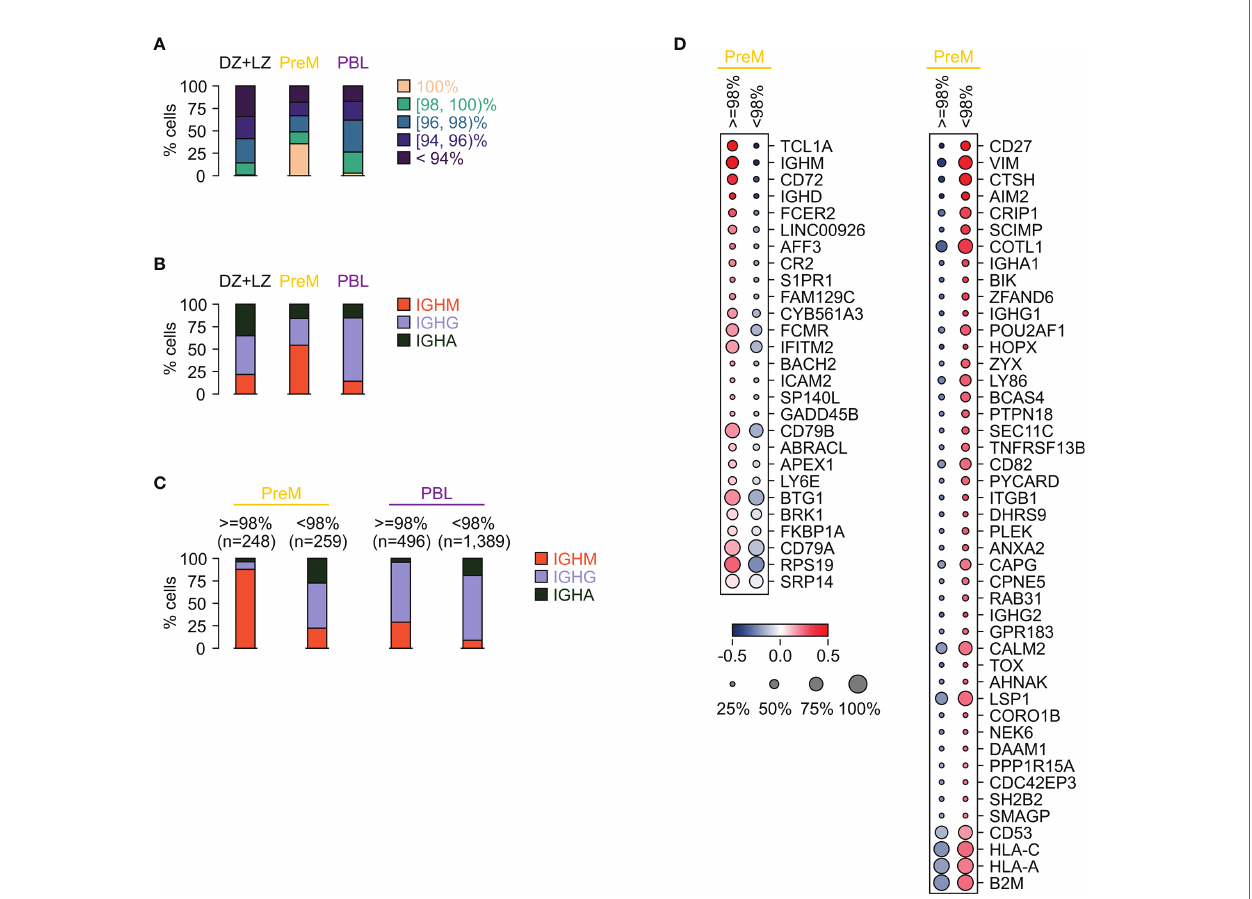
FIGURE 4 | PBL and PreM display unique immunoglobulin repertoires. (A) Stacked bar plot showing for the indicated cell populations, GC (DZ+LZ groups), PreM and PBL (PBL1+PBL2 clusters), the percentage of cells within the V-region germline identity subgroups. (B) Stacked bar plots showing for the indicated cell populations the percentage of cells within the immunoglobulin isotype classes. (C) Stacked bar plots showing for the PreM and PBL populations the percentage of cells within the immunoglobulin isotype classes in the fractions with high ( ≥ 98%) and low (<98%) V-region germline identity. (D) Heat map displaying the differentially expressed genes between PreM cells with high ( ≥ 98%) and low (<98%) V-region germline identity. The size of the dot indicates the percentage of cells with detectable expression, and the color re fl ects the relative gene expression shown as the z-scored average (log2) normalized expression. Only genes displaying a fold change ≥ 1.2 and detectable expression in at least 25% of the cells in either group are